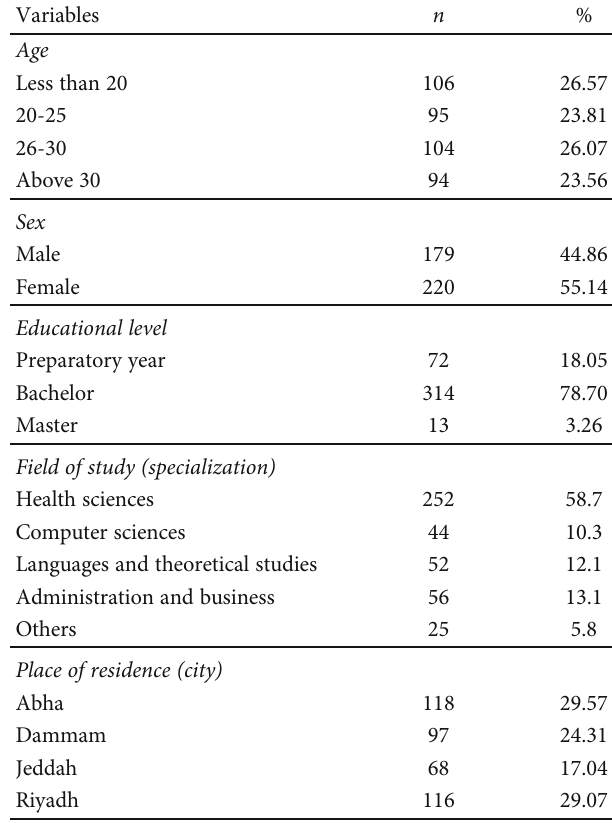
Table 1: Demographic characteristics of study participants ( N = 399